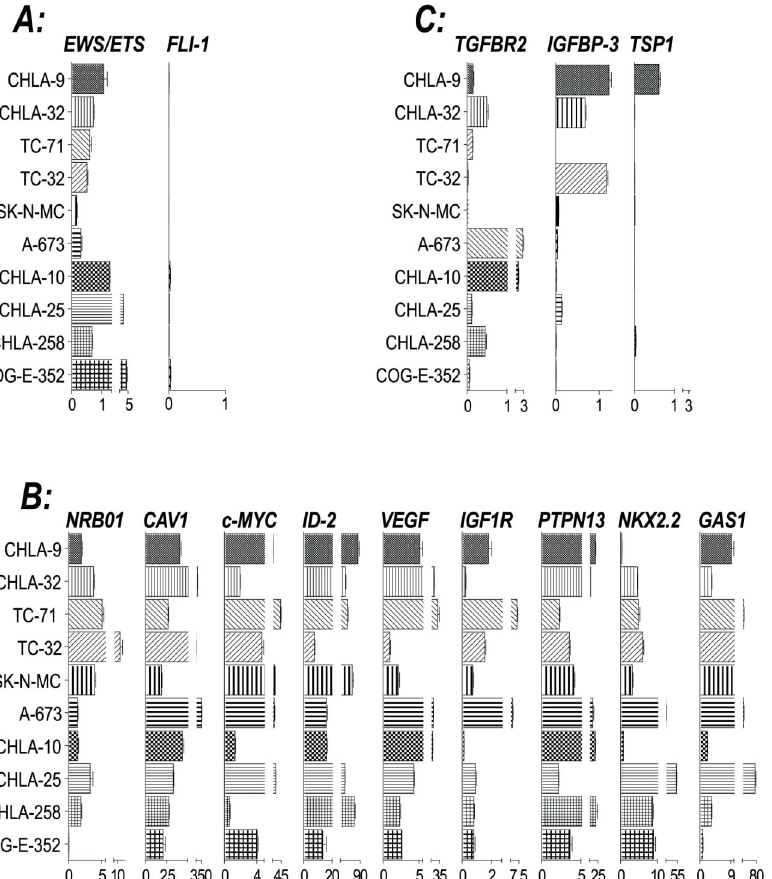
Figure 2. Gene expression survey of EFT cell lines. Expression as a percentage of the GAPDH transcript was assessed by real time quantitative PCR for the genes indicated. Panel A demonstrates the expression of EWS/ETS gene product along with native FLI-1. Panel B demonstrates high expression levels for a selection of loci known to be upregulated by EWS/ETS chimeric proteins. Panel C demonstrates low expression levels of loci shown to be downregulated by EWS/. ETS chimeric proteins.